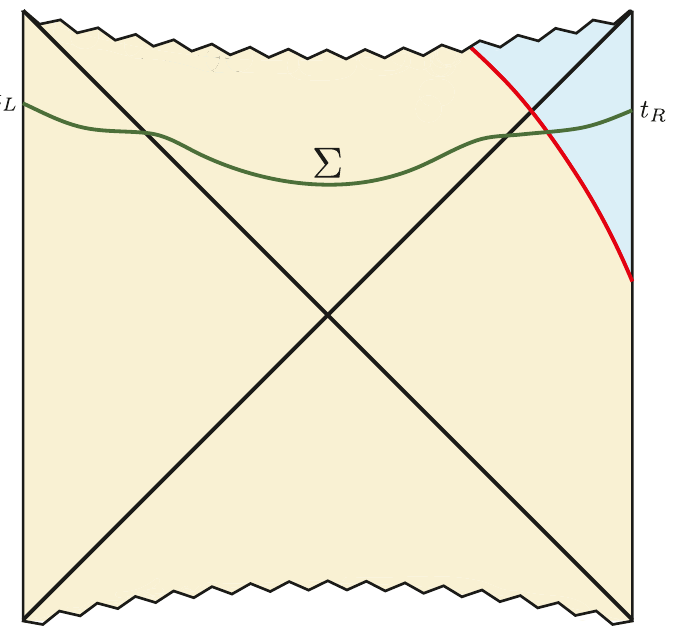
Figure 3 . Extremal codimension-one surface (cid:6) of interest. Its boundary @ (cid:6) consists of two spheres at in(cid:12)nity, located at times t L = t R = t